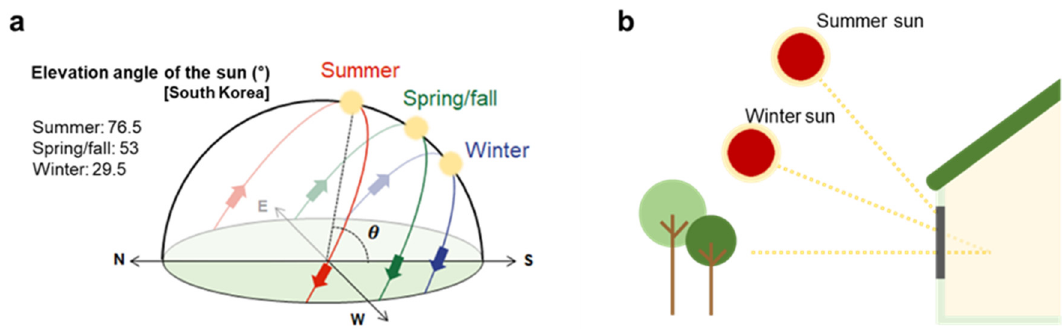
Figure 1. ( a ) Seasonal elevation angle of the sun in Korea. ( b ) Schematic of a tinted window in summer and winter. GHLC devices, comprising a host LC and guest dichroic dye, have attracted consider-